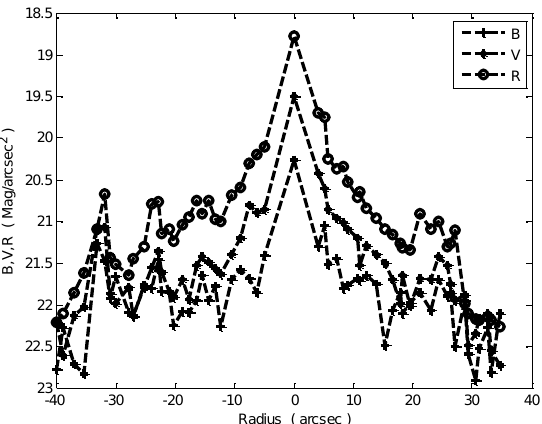
Fig.3: Photometric profiles along the major axis of NGC 4448.